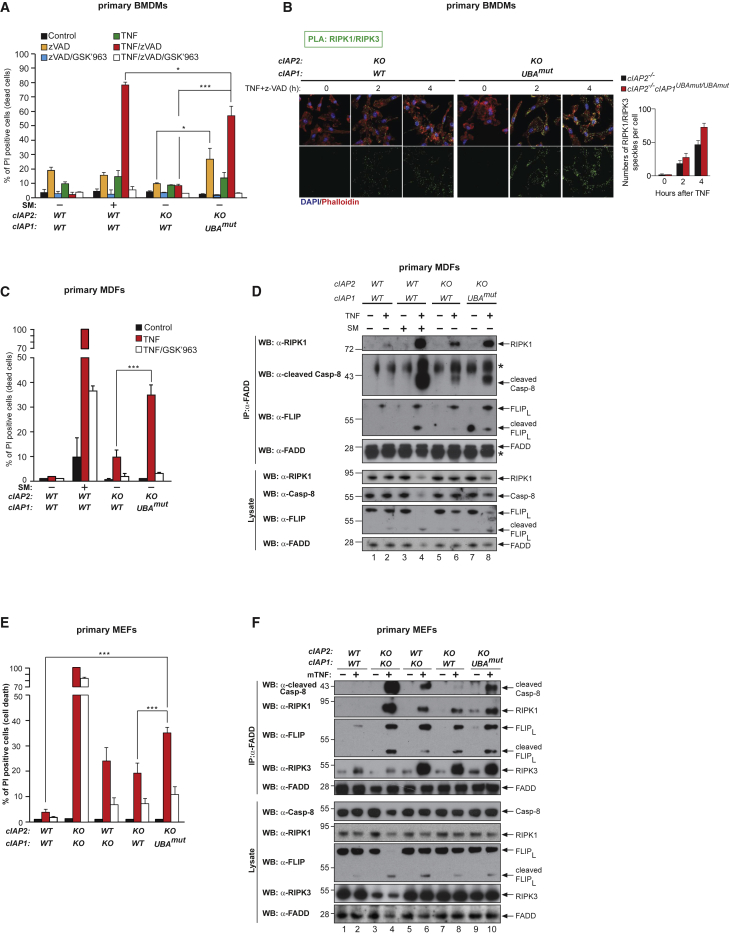
Mutation in the UBA Domain Switches the TNF Response to Cell Death(A, C, and E) Primary BMDMs (A), MDFs (C), and MEFs (E) of the indicated genotypes were treated as shown (TNF 100 ng/mL, GSK′963 100 nM, SM 100 nM, for BMDMs TNF 1 ng/mL) for 24 hr followed by quantification of propidium iodide (PI)-positive cells. Data are presented as mean ± SD, n > 3, ∗p < 0.05, ∗∗∗p < 0.001; statistics were performed using two-way ANOVA.(B) PLA of primary BMDMs from cIAP2−/− and cIAP1UBAmut animals using RIPK1 and RIPK3 antibodies. Cells were stimulated with 1 ng/mL TNF for the indicated time points. The graph to the side indicates the quantification of RIPK1/RIPK3 PLA speckles. The graph shows mean ± SD.(D and F) Primary MDFs (D) and MEFs (F) of the indicated genotypes were treated for 4 hr as indicated (TNF 100 ng/mL, z-VAD-FMK 10 μM), followed by FADD IP and western blot analysis for the indicated proteins. Images are representative of three independent experiments. Graphs show mean ± SD, ∗p < 0.05, ∗∗∗p < 0.001.